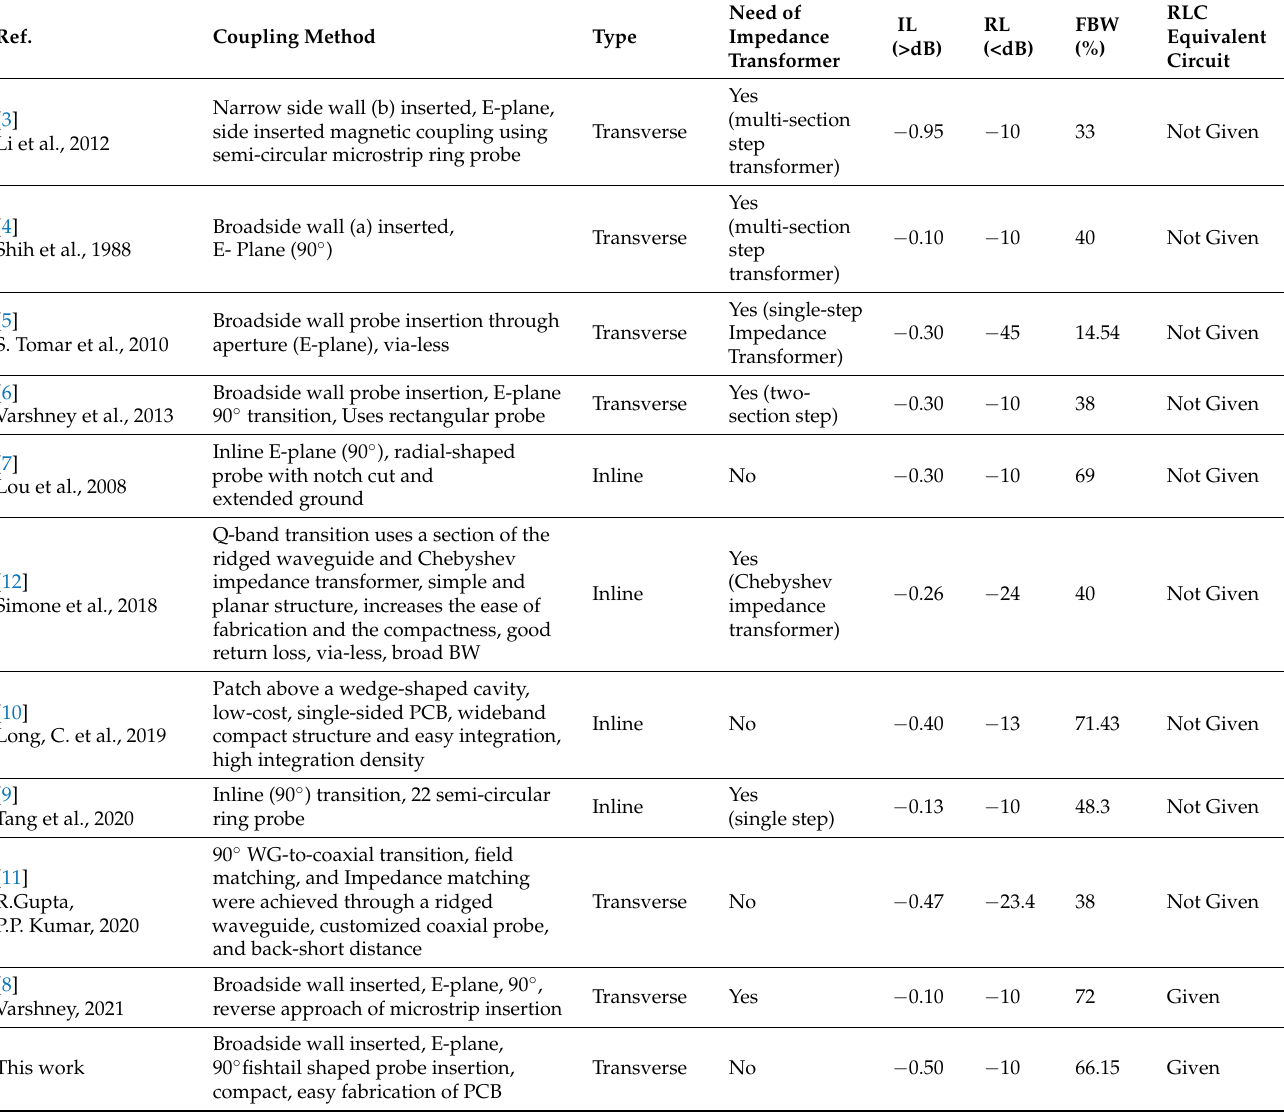
Table 6. Ka-band Rectangular Waveguide to Microstrip Line Transition Design